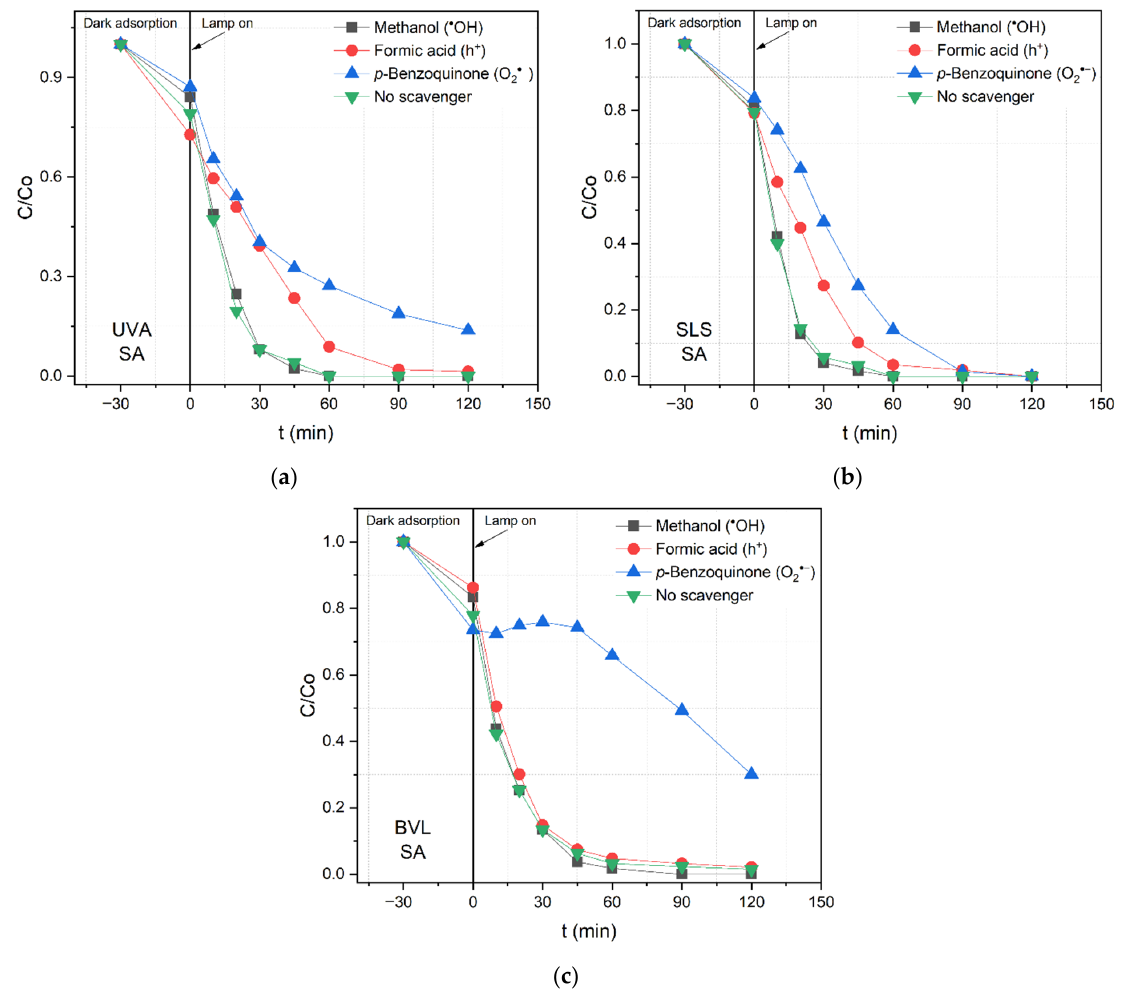
Figure 8. Photocatalytic salicylic acid (SA) degradation by N/TiO 2 /rGO with 0.25 wt.% of rGO material in the presence of different scavenger agents under ( a ) UVA light, ( b ) solar light simulator (SLS), and ( c ) blue visible light (BVL). Table 7. UV and global irradiation values of each lamp at two distances to the